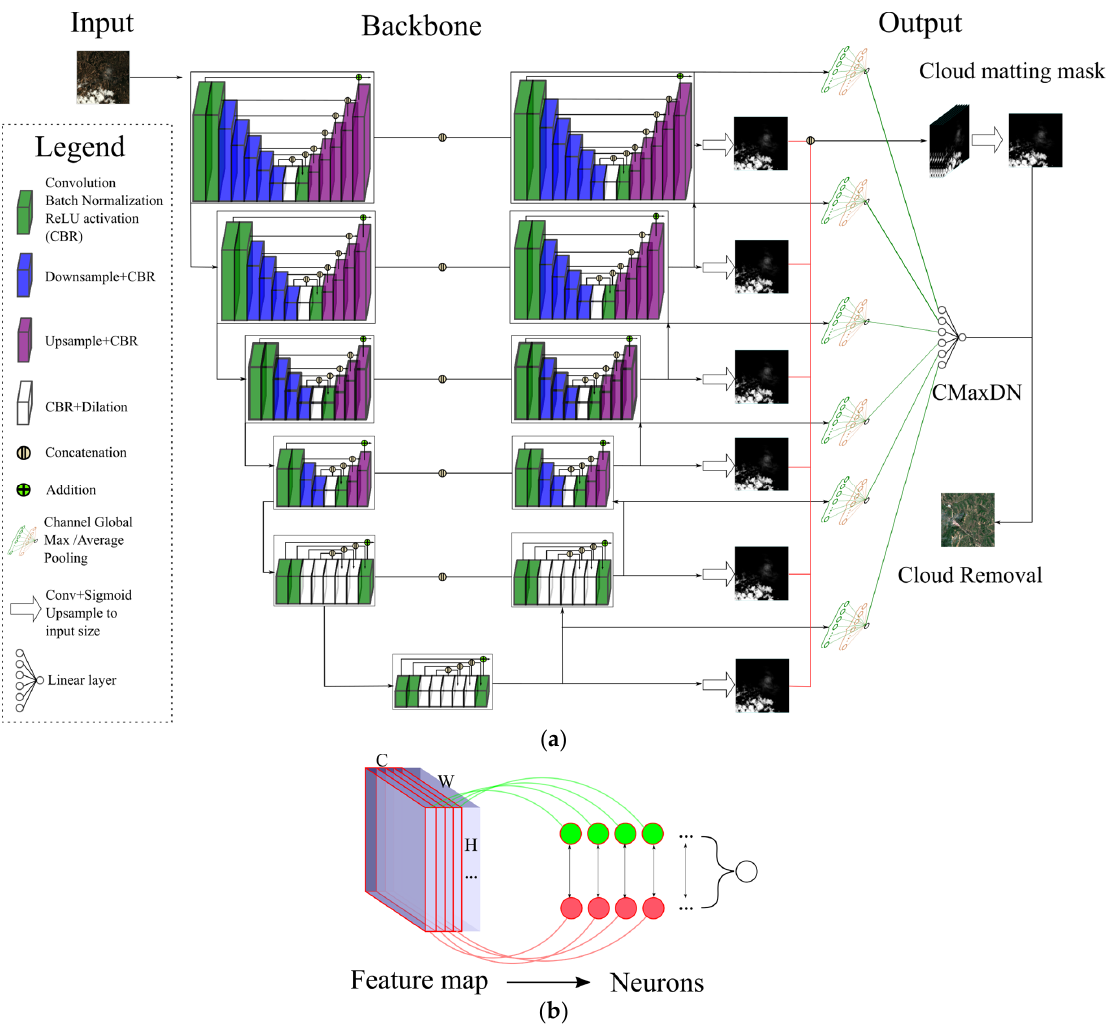
Figure 3. ( a ) SCM-CNN(U 2 Net) model. ( b ) Channel global Average and Max Pooling. Where C, W, and H represent the number of channels, width and height of the image, respectively. Firstly, each channel of the feature map is fused into one neuron, and secondly, multiple neurons are further fused into one neuron. Furthermore, this neuron is the